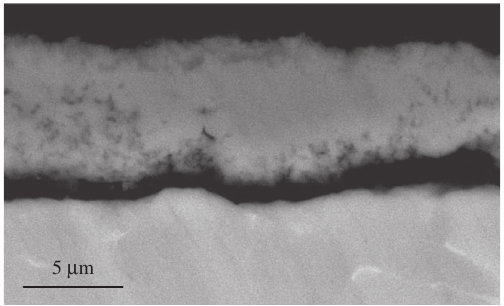
Figure 7: Micrograph (SEM/BEI) of a cross section of Ti-6Al-4V oxidized in air at 650°C for 24 h.